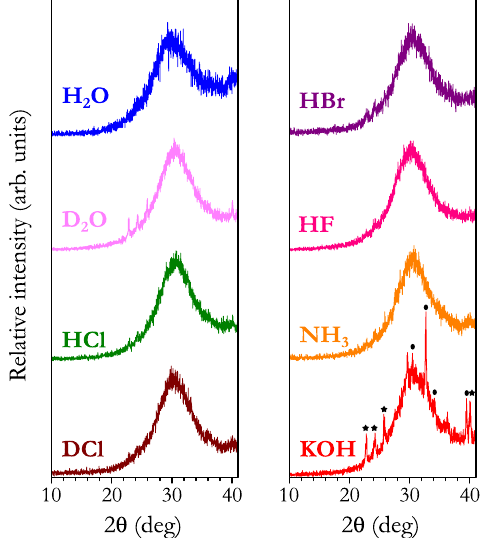
FIG. 2. Powder x-ray characterization of eHDA samples (recorded at 80 K) in undoped form or with the indicated dopants. Stars and circles mark hexagonal ice and ice XII,